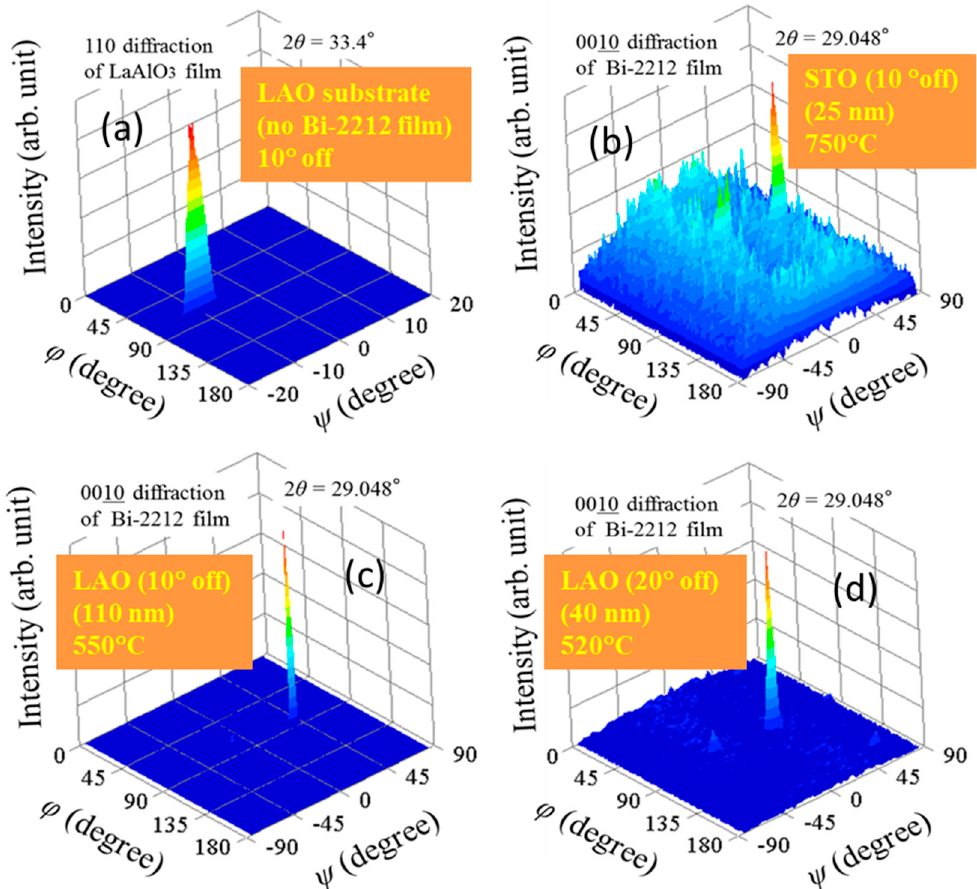
Figure 6. XRD  ‐ ψ scans for the ( a ) (110) LaAlO 3 (LAO) substrate (110) plane, 2 θ = 33.4  ) and ( b – d ) Figure 6. XRD ϕ - ψ scans for the ( a ) (110) LaAlO 3 (LAO) substrate (110) plane, 2 θ = 33.4 ◦ ) and ( b – d ) non c ‐ axis Bi ‐ 2212 thin films (0010) plane, 2 θ = 29.048  ) obtained for different growth temperatures on non c -axis Bi-2212 thin films (0010) plane, 2 θ = 29.048 ◦ ) obtained for different growth temperatures on different vicinal substrates. Positions (  , ψ ) of the peaks in ( a , b , c , d ) are: (81  , − 10  ), (90  , 37  ), (90  , different vicinal substrates. Positions ( φ , ψ ) of the peaks in ( a – d ) are: (81 ◦ , − 10 ◦ ), (90 ◦ , 37 ◦ ), (90 ◦ , 36 ◦ ), 36  ), and (91  , 25  ), respectively. and (91 ◦ , 25 ◦ ),